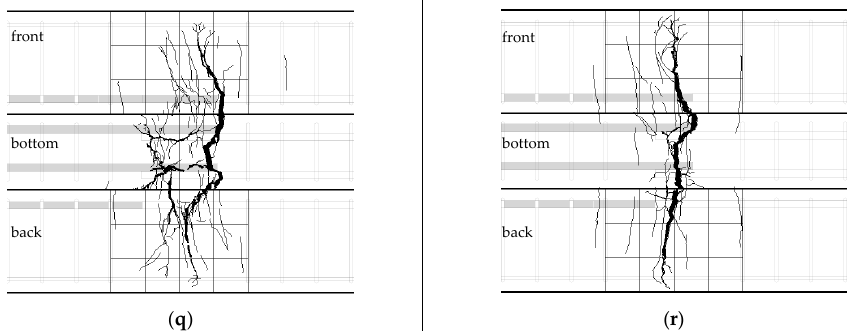
Figure 6. Cracking aspect of test specimens at lap-spliced region: ( a ) 120-0-0; ( b ) 120-15db-0; ( c ) 120-10db-0; ( d ) 120-5db-0; ( e ) 180-0-0; ( f ) 180-15db-0; ( g ) 180-10db-0; ( h ) 180-5db-0; ( i ) 120-10db-V1.5; ( j ) 120-5db-V1.5; ( k ) 180-10db-V2.0; ( l ) 180-5db-V2.0; ( m ) 120-0-V1.5; ( n ) 180-0-V2.0; ( o ) 180-0-V1.5; ( p ) 180-5db-V1.5; ( q ) 180-10db-V1.0; ( r ) 180-5db-V1.0.